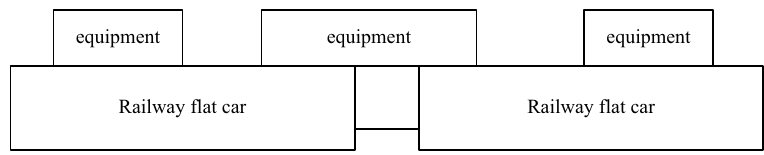
Figure 3: Correct loading method: no continuous straddle loading.